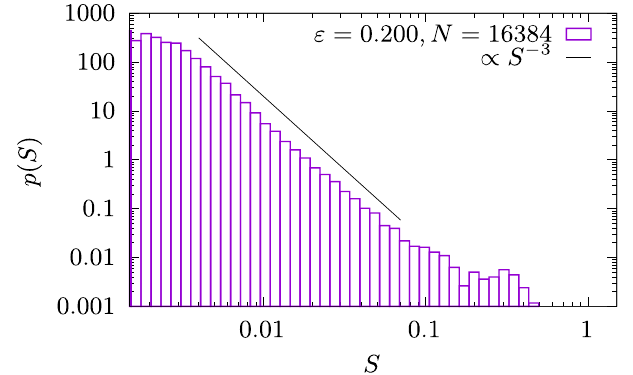
Fig. 9 Cluster size distribution for hypergraph on a lattice. Distribution of the cluster sizes, S , for system of size N = 16,384, at con fi dence value ε = 0.2, for the HOID model on a lattice with edge size k = 3 and connectivity c